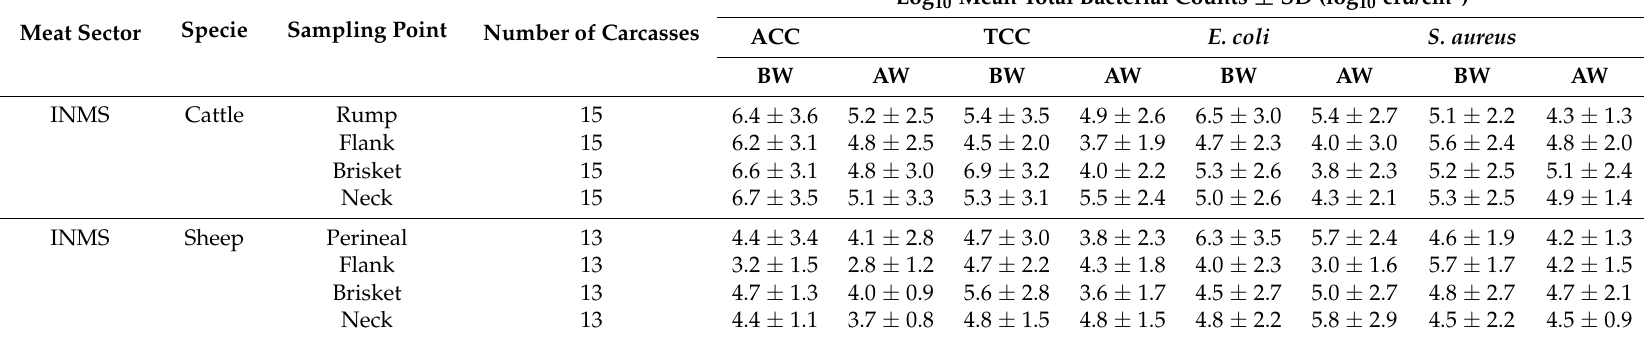
Table 3. The logarithm 10 of mean total bacterial counts for cattle meat samples from selected location in the informal meat sector in the Eastern Cape Province, South